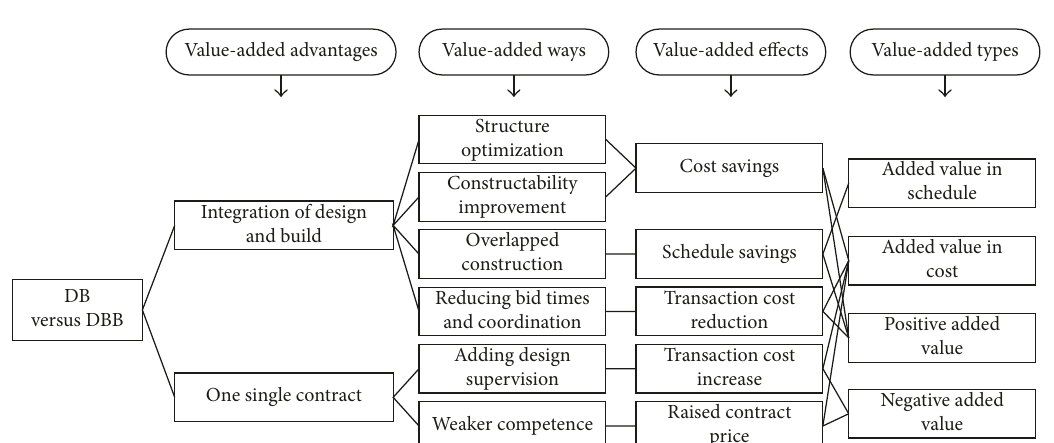
Figure 7: Main value-added features and their effects.